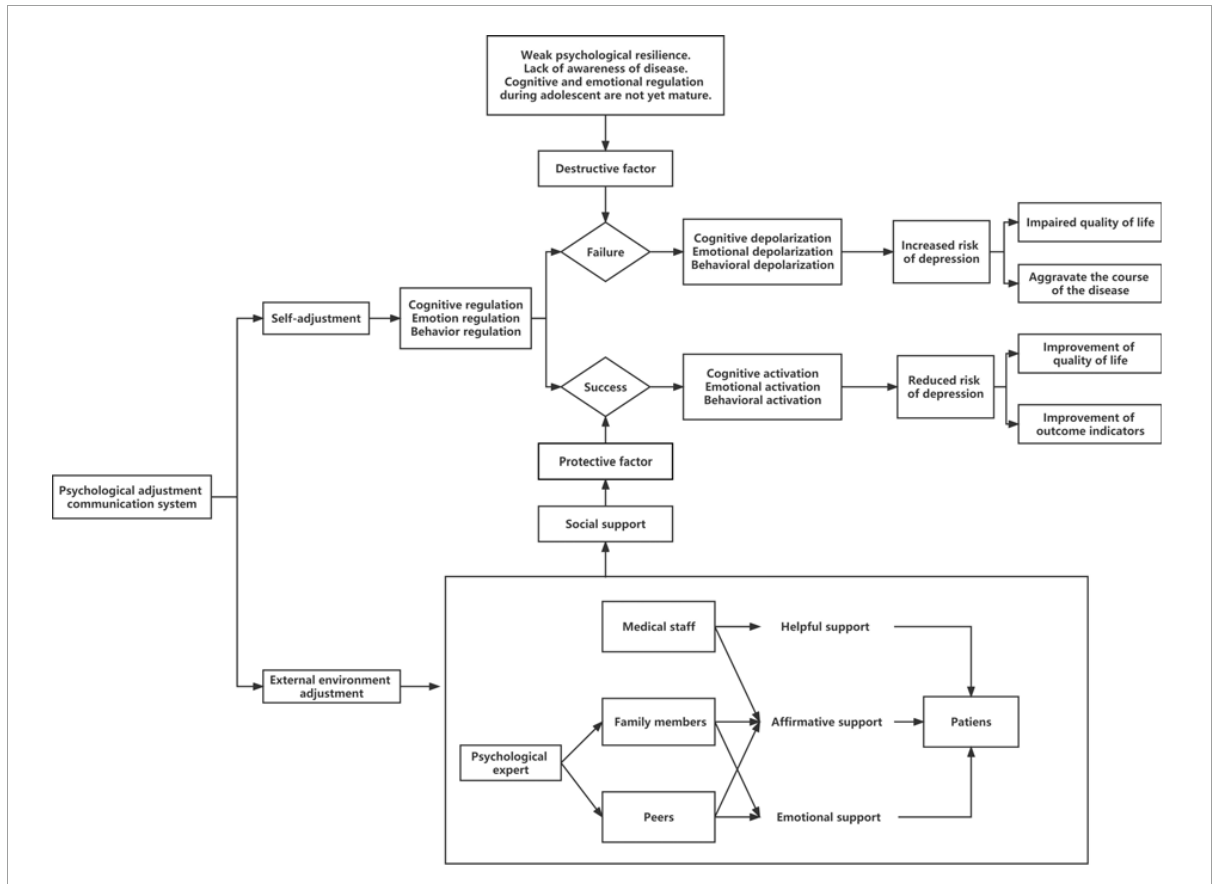
FIGURE1 A conceptual framework for the psychological adjustment communication system based on social support theory.